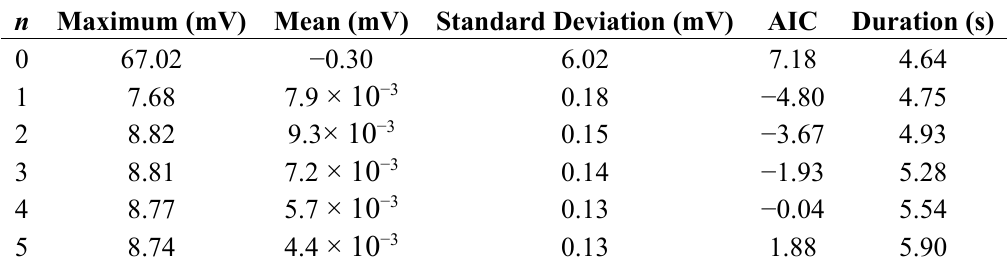
Table 2. Statistical results of voltage prediction error.